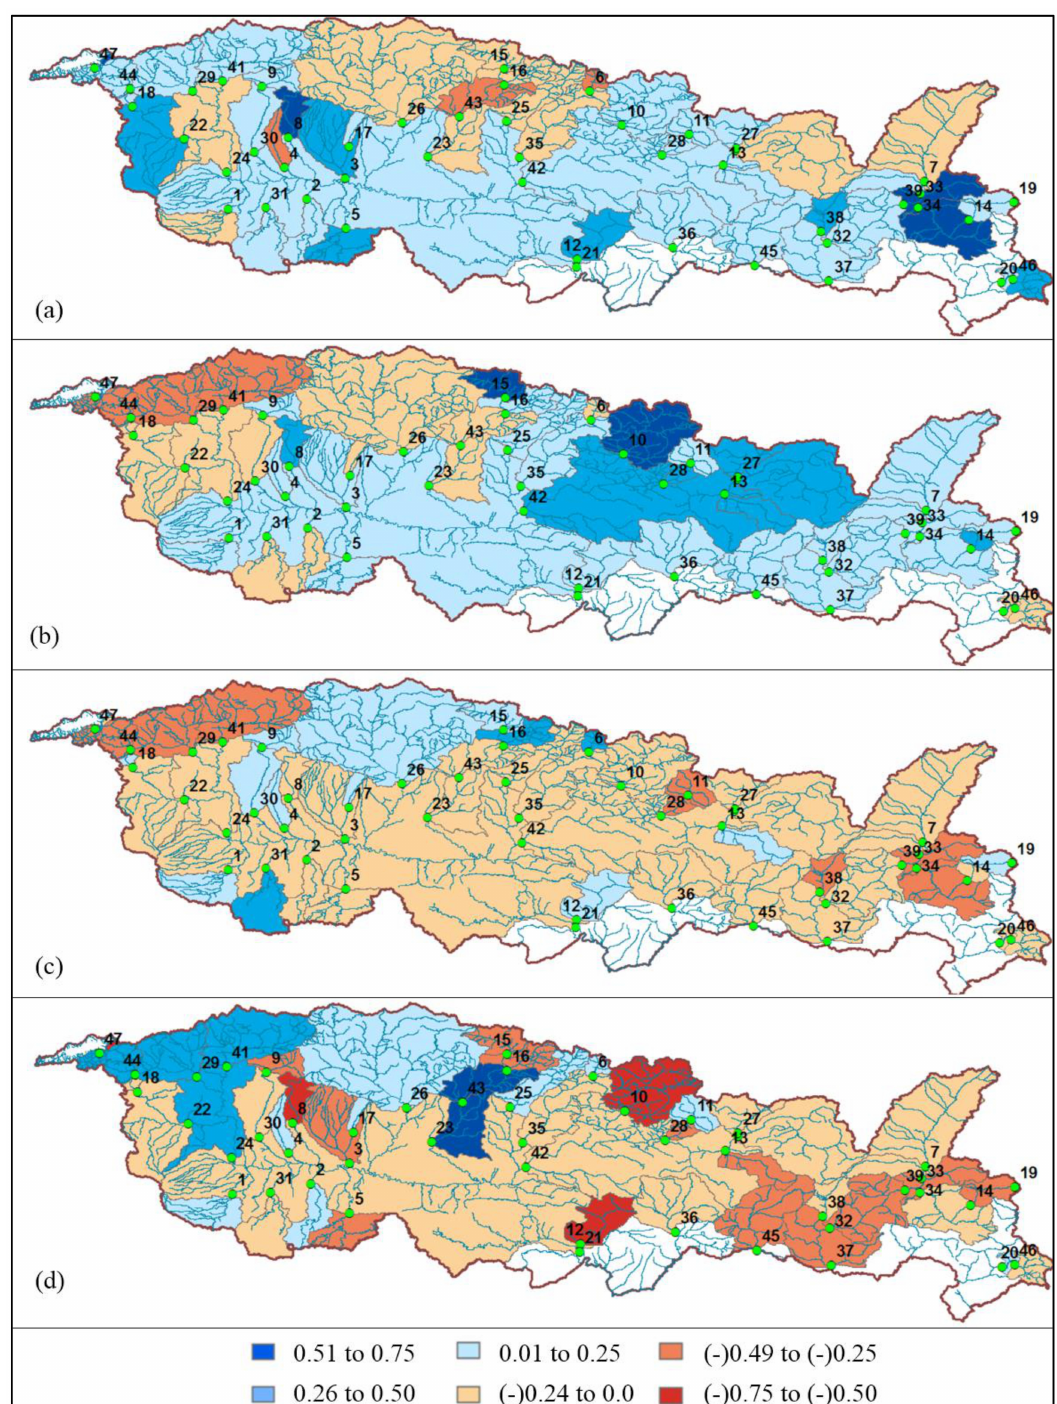
Figure 10. Distribution of averaged SDI-12 values over the basin for 10-year period intervals: ( a